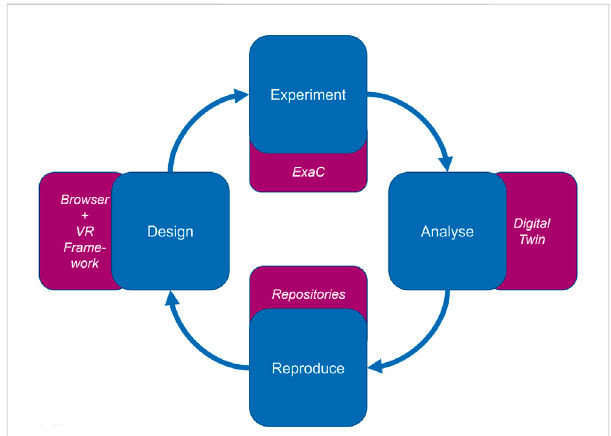
FIGURE 1 Overview of the DEAR principle. The design phase happens in a browser with an existing VR framework as a backup. The experiment phase uses an implementation of the Experiment as Code (ExaC) paradigm to provision, deploy, and run the experiment and enable the collection of data. The analyse phase uses a digital twin to represent the experiment and enable real-time management, as well as statistical evaluation of results. Lastly, the reproduce phase ensures that the experiment setup, the collected data, and the proposed analysis are available in repositories. These repositories can beused as an input to the next design